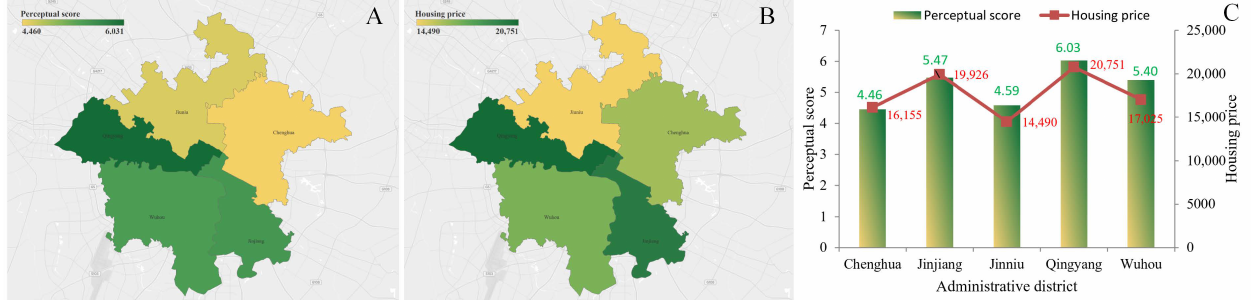
Figure 16. Results of comparison between perceptual scores and housing prices in the main administrative district of Chengdu. Map ( A ) shows our predicted perceptual scores, map ( B ) shows housing price statistics and the mixed chart ( C ) shows specific statistics of the perceptual score and housing